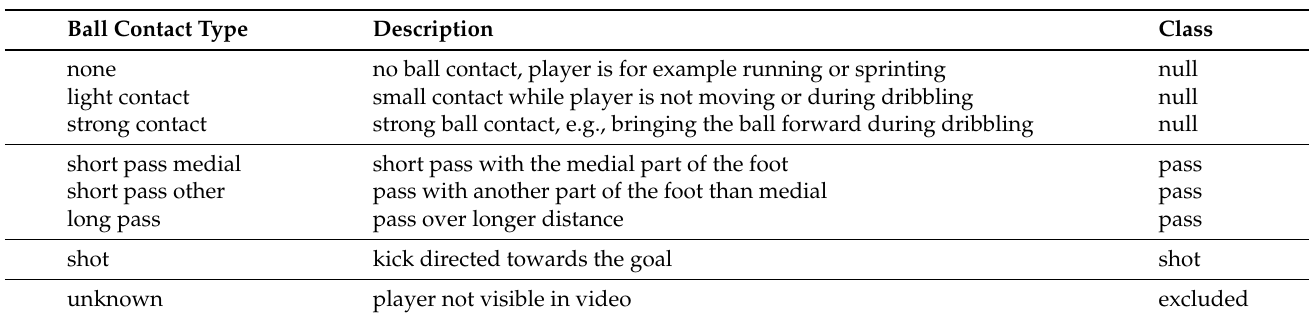
Table 1. Overview of the ball contact types, their definitions and their class affiliation for the three-class problem shot versus pass versus